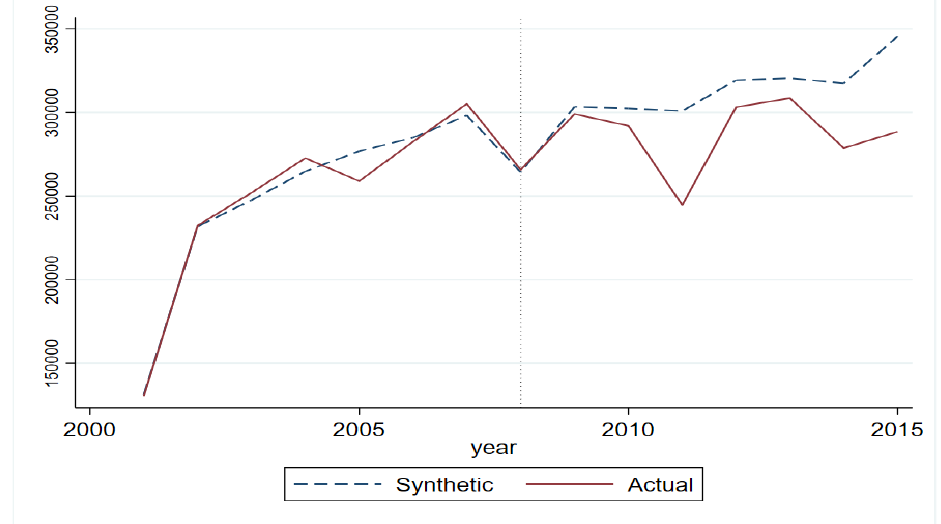
Figure 3. Fossil fuel consumption in three treatment states — California, Massachusetts, and Washington — using actual and synthetic data .